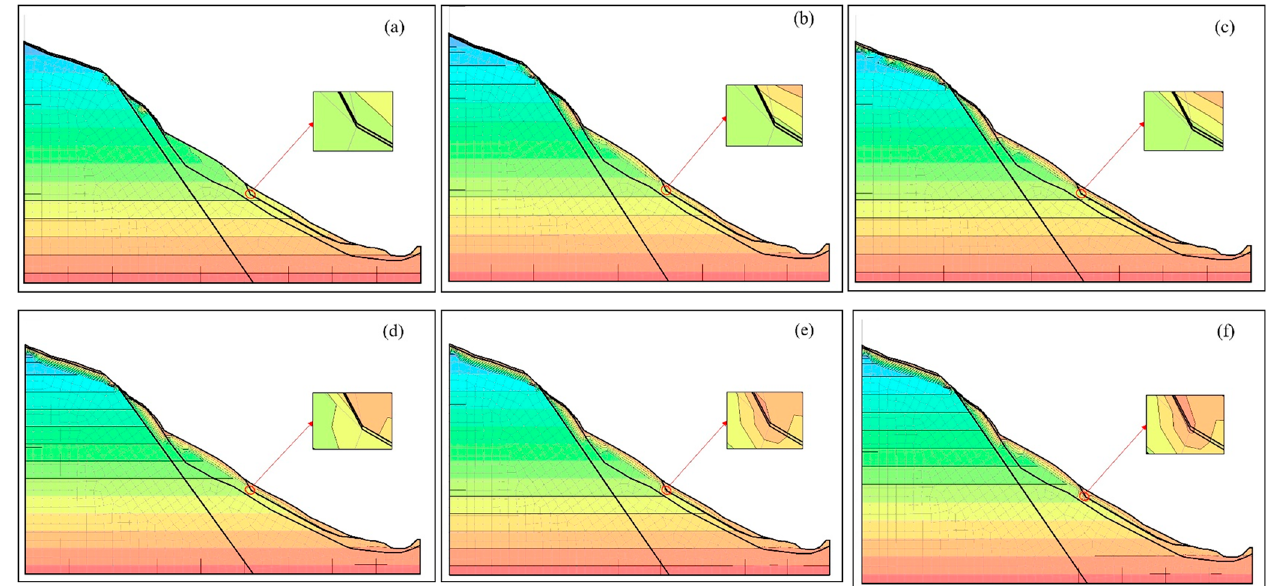
Figure 11. Nephogram showing the evolution of pore water pressure accompanied by rainfall. ( a ) 2019-7-18 ( b )2019-7-24 ( c ) 2019-7-30 ( d )2019-7-5 ( e )2019-7-11 ( f